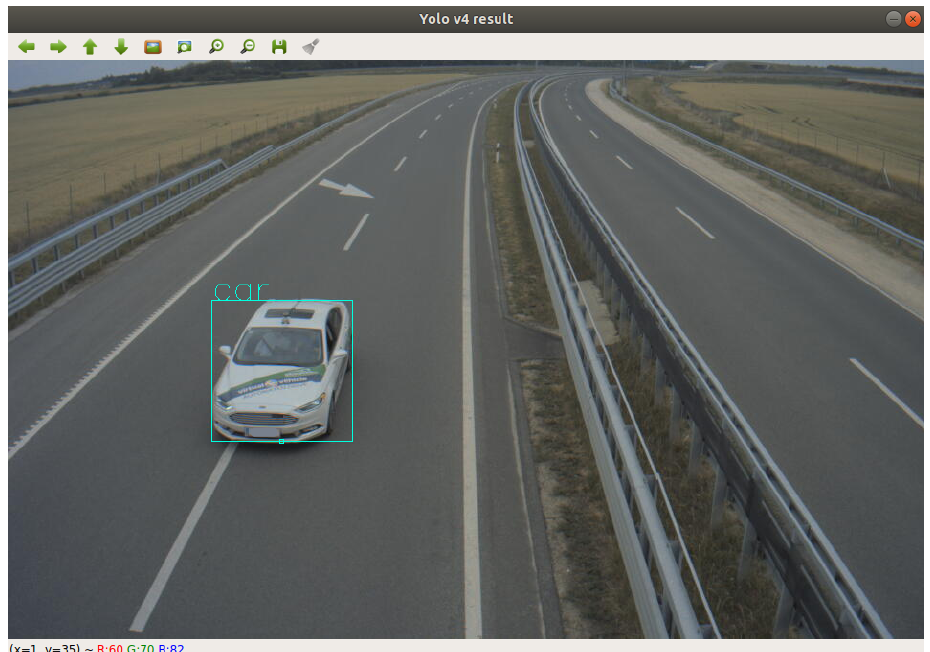
Figure 30. Bounding box drew around the detected